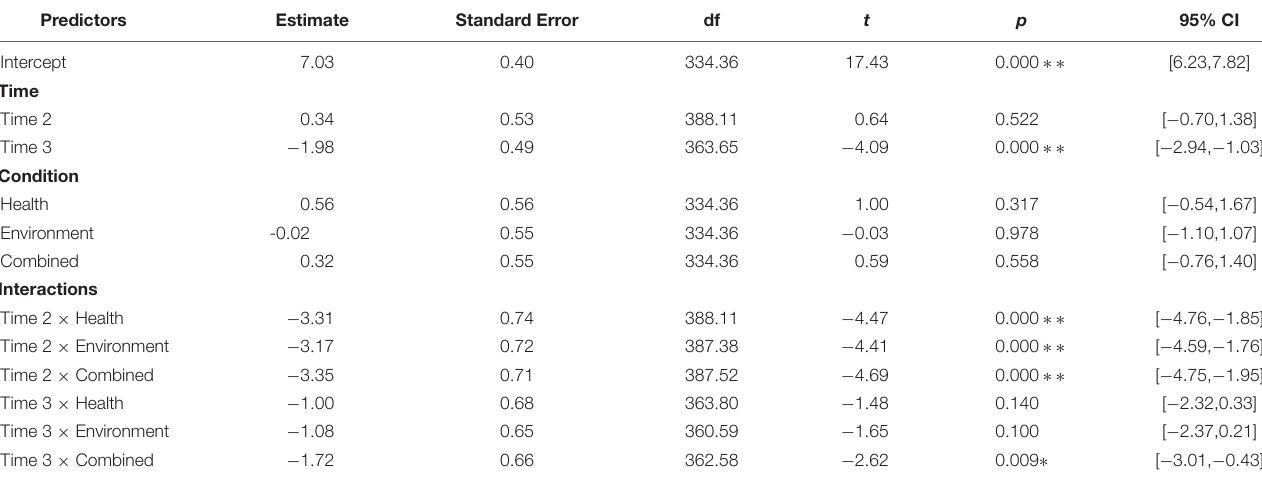
FIGURE 1 | Average red and processed meat consumption across time. Error bars represent standard error ± mean. TABLE 2 | Multi-level model regression coefficients for red and processed